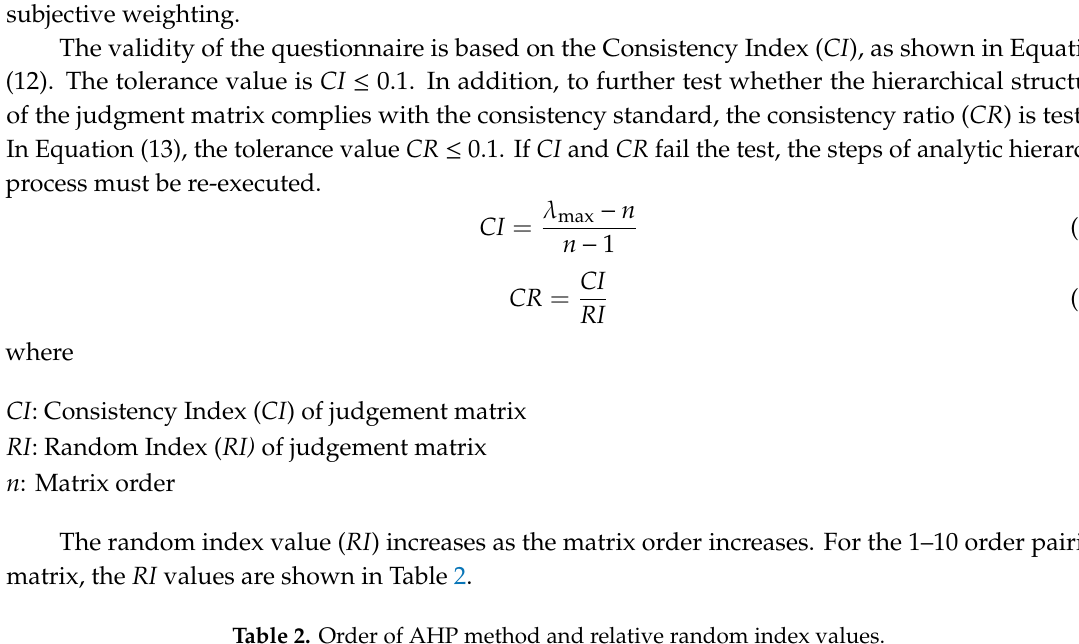
Table 2. Order of AHP method and relative random index